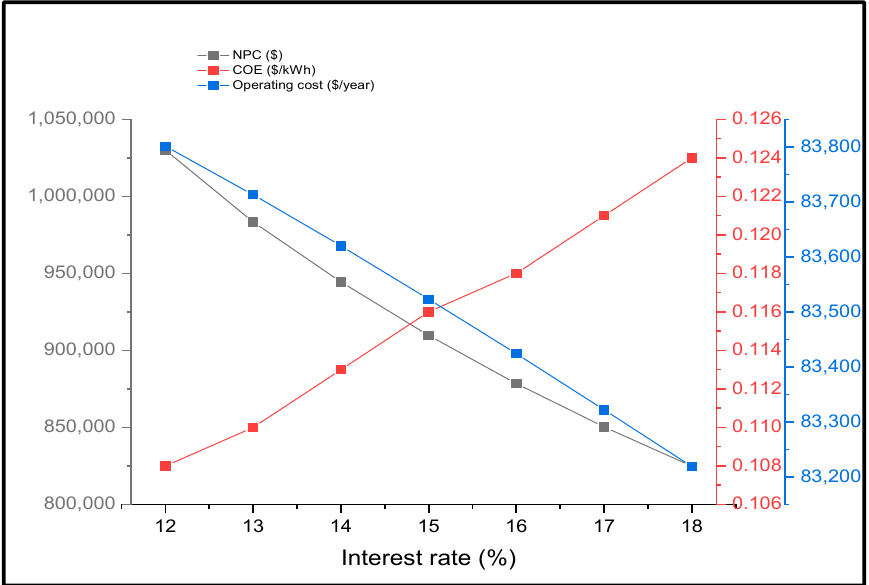
Figure 12. Effect of increasing interest rate on the operating cost, net present cost (NPC), and cost of energy (COE) .